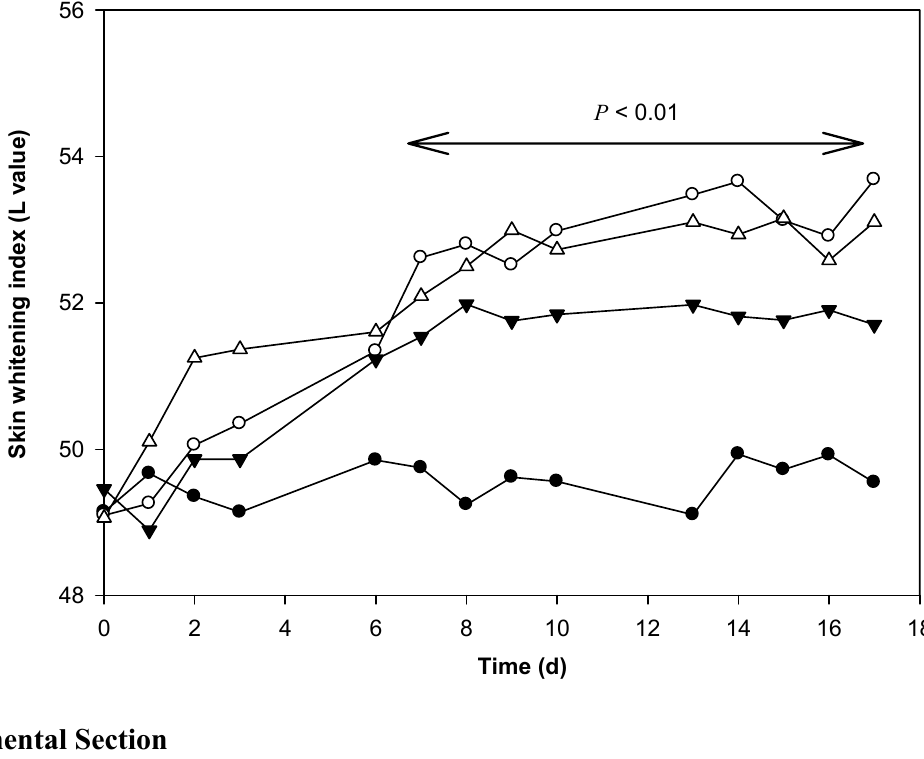
Figure 6. Time Course of Skin Whitening Index (L value) of Mice Treated with Vaseline only (control, ● ), 2% HQ ( ○ ), 0.2% RK ( ▼ ) or 2% RK ( △ ) in Vaseline. A total of thirty-two mice were equally divided into four groups and each group was smeared twice daily in 5 consecutive days a week for 3 weeks with 0.1 g Vaseline (control, ● ), 2% HQ in Vaseline ( ○ ), 0.2% RK ( ▼ ) or 2% RK in Vaseline ( △ ). The L value was measured once a day on the same skin area with a Chromameter CR-2300d. Averaged L values (n = 8) with an error bar of SD are plotted over the experimental period. A value of p < 0.01 by Student’s t -test by comparing the data with that of control at the same time was considered statistically